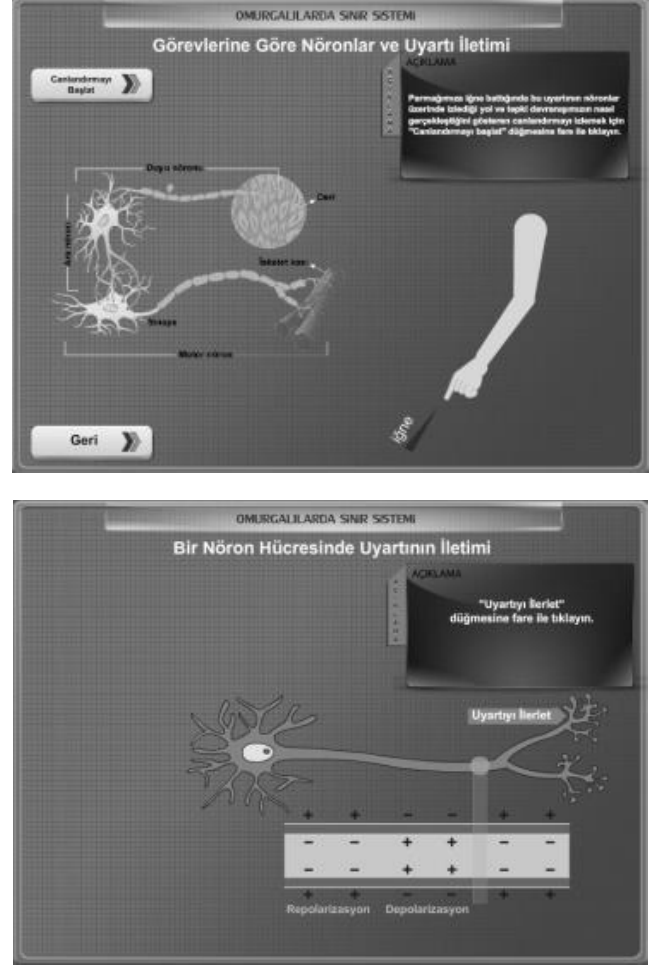
Figure 3 Simulation’s screenshots used as an Mbio